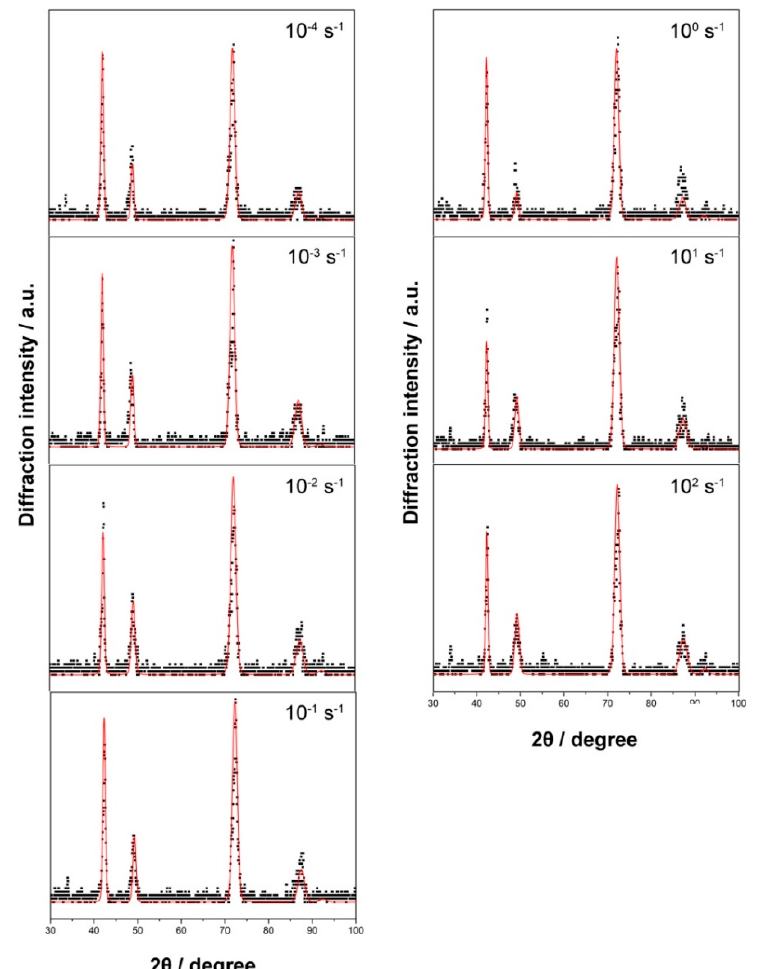
Figure 8. The fitting results of X-ray di ff raction (XRD) patterns at various strain rates using materials analysis using di ff raction (MAUD)